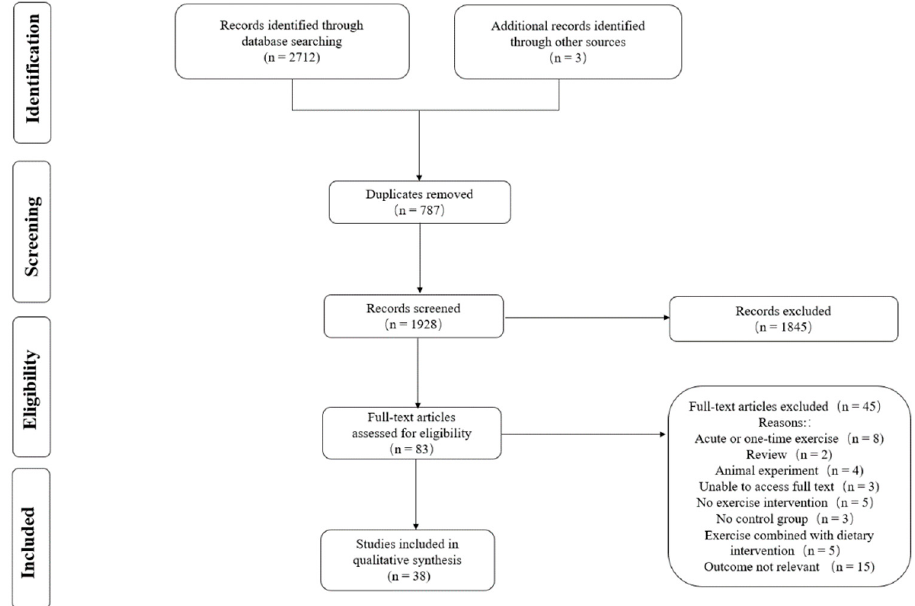
Figure 1. PRISMA flow